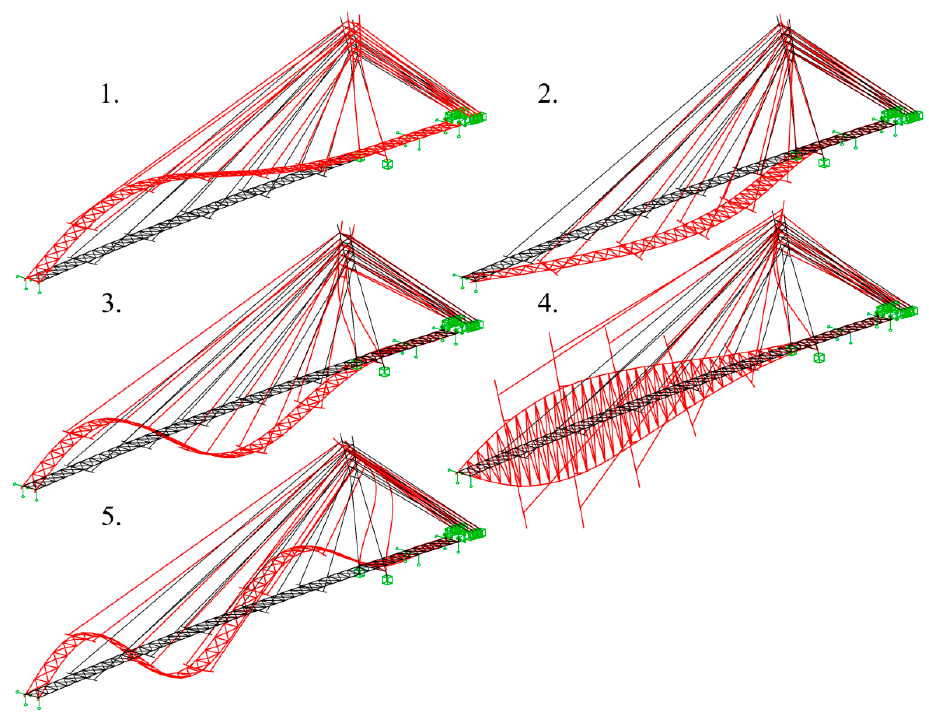
Figure 11. Modal shapes: 1. f 1V = 1.35 Hz (vertical), 2. f 1H = 1.41 Hz (horizontal), 3. f 2V = 2.47 Hz (vertical), 4. f 1T = 2.89 Hz (torsional), 5. f 3V = 4.18 Hz (vertical).